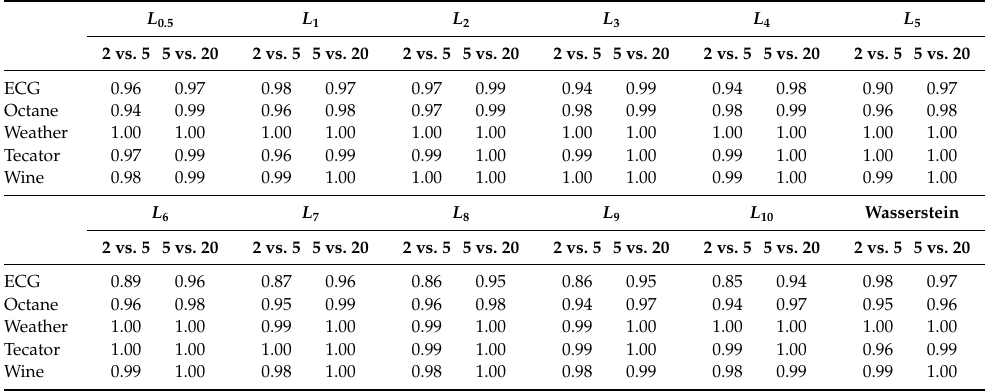
Table A1. Spearman correlation between LOF scores based on embeddings of different dimensionality for the 5 considered real datasets and metrics L 0.5 , L 1 , ..., L 10 , and unnormalized L 1 -Wasserstein. MDS embeddings with 5 dimensions are compared to embeddings with 2 (2 vs. 5) and 20 (5 vs. 20)